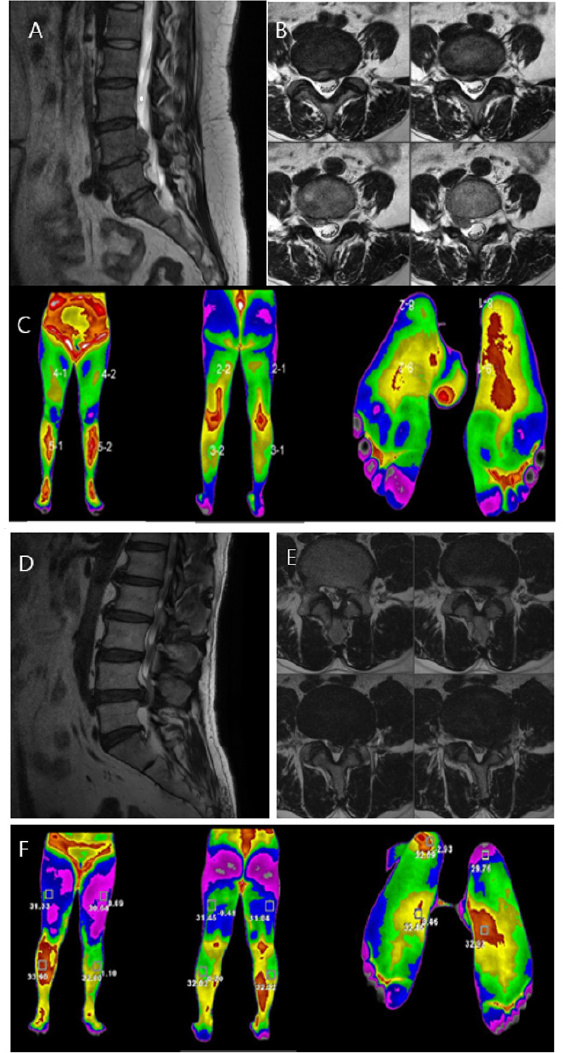
Figure 4. Case comparison of the differences in the lower leg temperature distribution according to pain severity in patients with lumbosacral radiculopathy. ( A , B ): MRI showing HLD L4/5, Rt. with upward migration. Sagittal and axial views. ( C ): DITI image showing high temperature at L4/5 dermatome, right side. ( D , E ): MRI showing HLD L4/5, Lt. Sagittal and axial views. ( F ): DITI image showing high temperature at L4/5 dermatome, right side with high temperature difference between both sides.